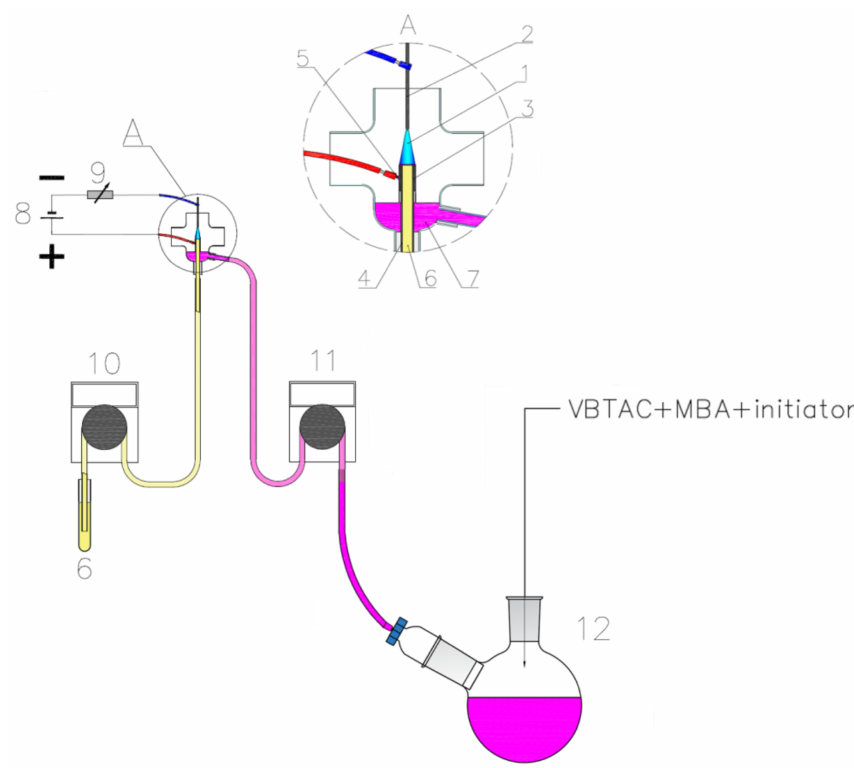
Figure 1. Developed system for the production of Au/VBTAC- co -MBA nanocomposite. 1—direct current atmospheric pressure glow discharge (dc-APGD), 2—a tungsten cathode, 3—a graphite tube, 4—a quartz capillary, 5—a platinum wire attached to the graphite tube, 6—a gold nanoparticles